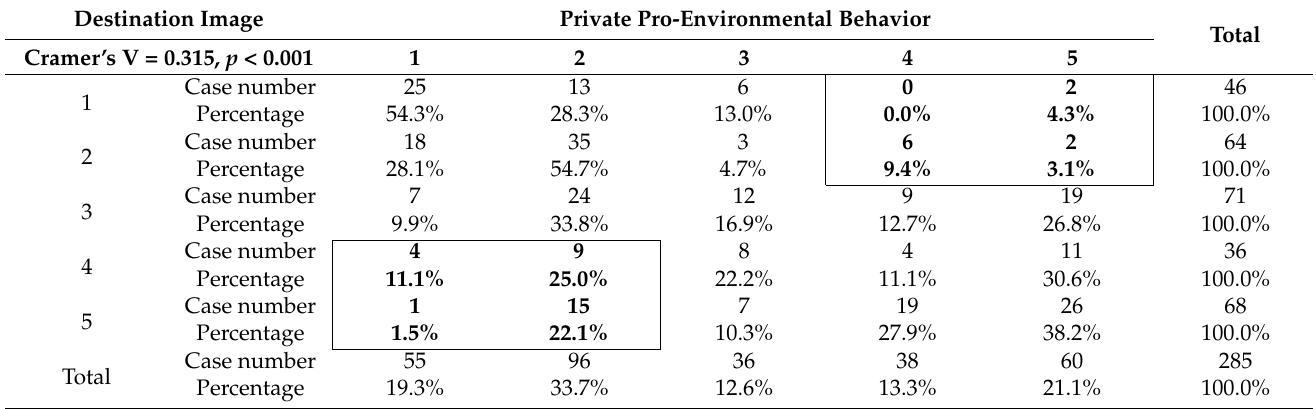
Table 6. Cross-contingency table of destination image and private pro-environmental behavior.